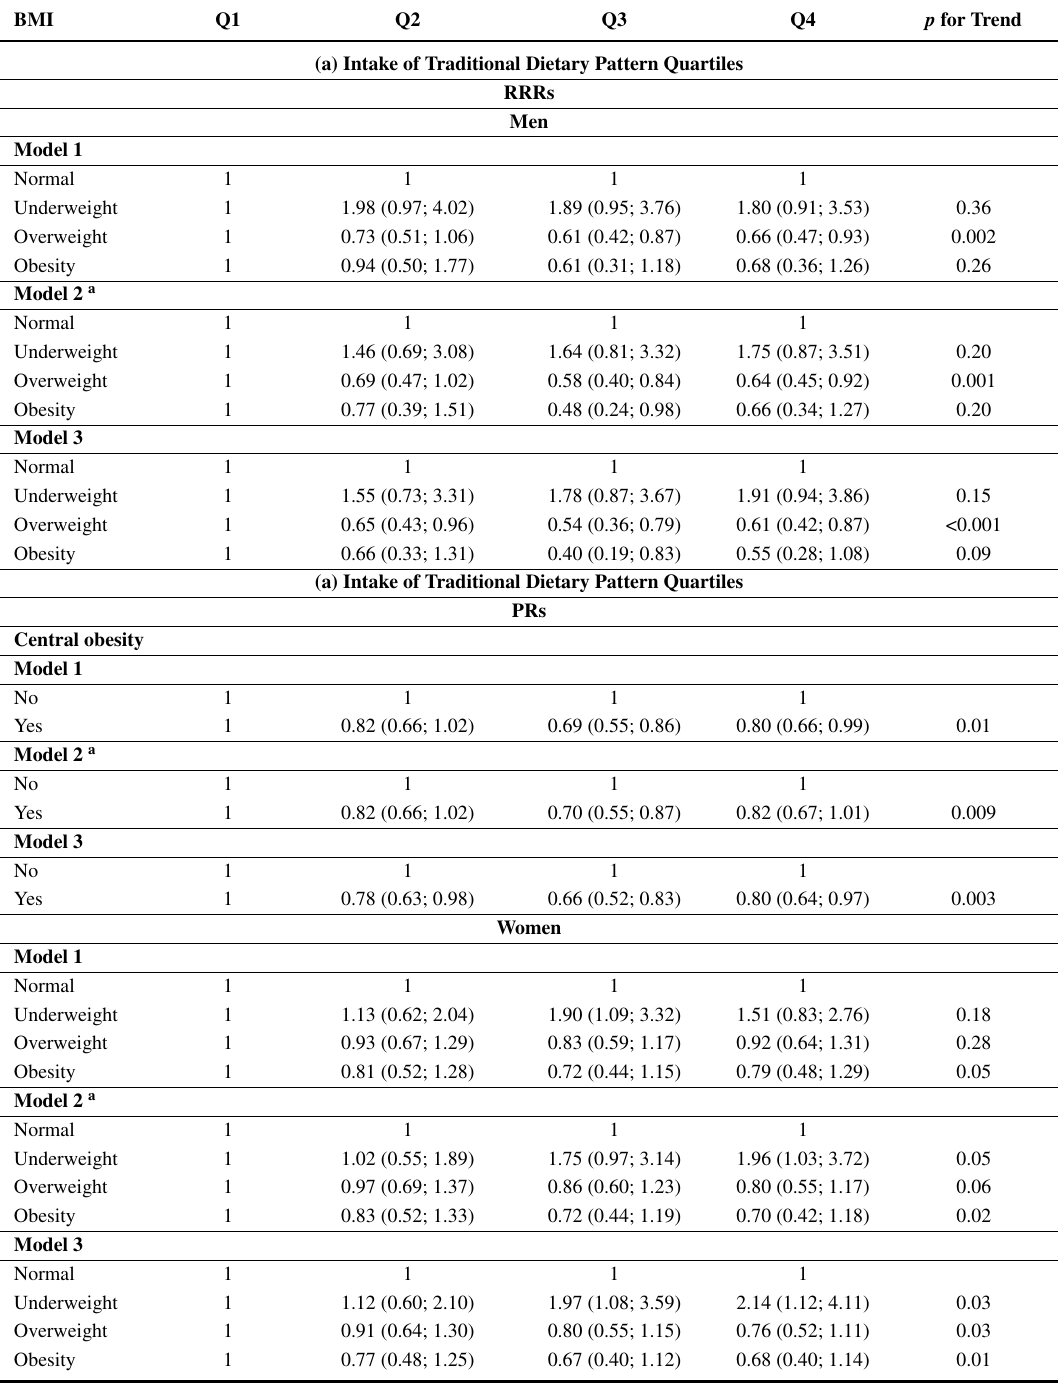
Table 3. Relative Risk Ratios (RRRs)/Prevalence Ratios (PRs) and 95% confidence interval (CI) for traditional and modern dietary pattern, stratified by